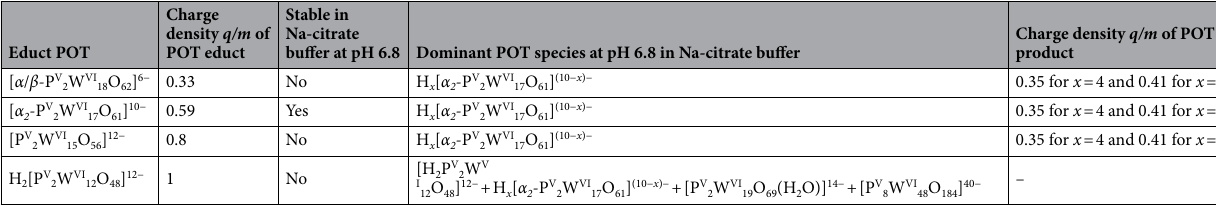
Table 2. Stability under physiological conditions and charge densities ( q/m ) of [ P 2 W 18 ] 6− , [ P 2 W 17 ] 10− , [